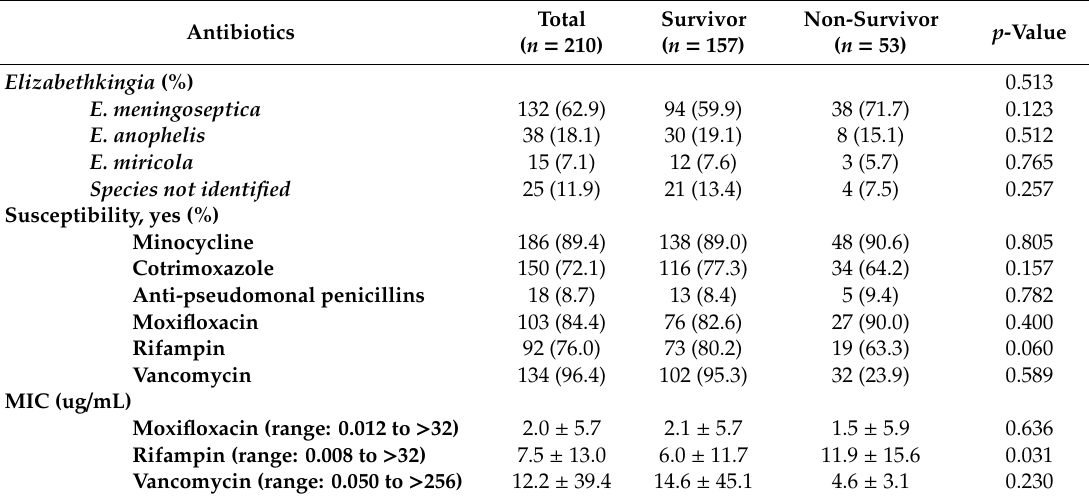
Table 3. Antibiogram patterns of Elizabethkingia spp . infection.